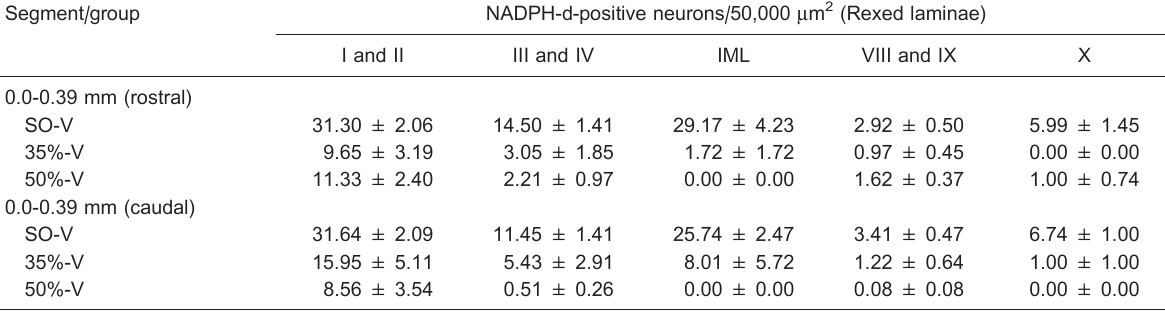
Table 1. Density of NADPH-d-positive neurons in the Rexed laminae according to experimental group and segment in relation to the compression site.